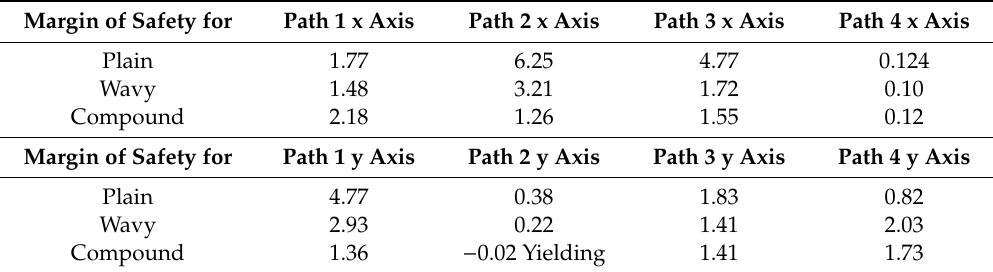
Table 7. Interaction equation along four